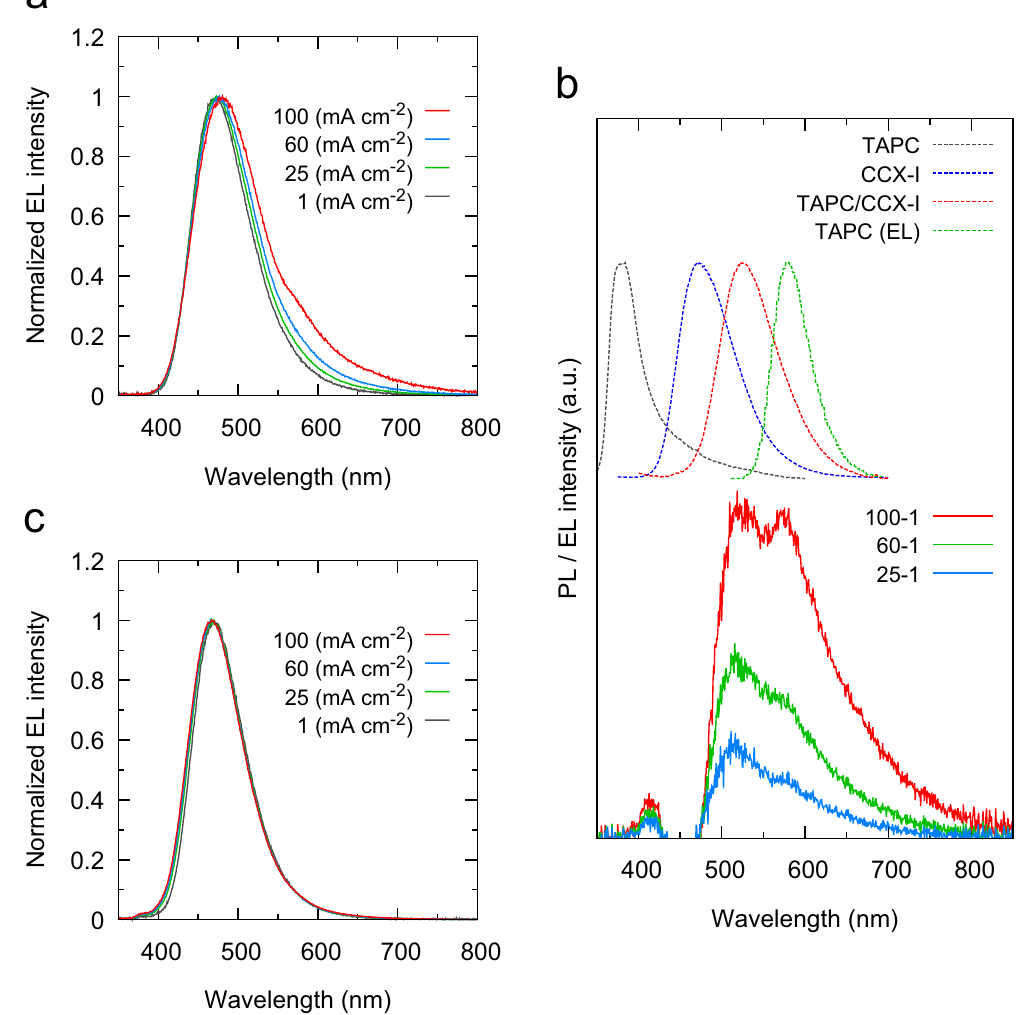
Figure 3. EL spectra of CCX-I based OLEDs. ( a ) EL spectra of CCX-I-6A at J values of 1, 25, 60, and 100 mA cm − 2 , with luminance of 88, 961, 1027, and 706 cd m − 2 , respectively. ( b ) Difference of EL spectra of CCX-I-6A (solid lines) and PL spectra of CCX-I, TAPC, and 50 wt% CCX-I:TAPC film together with EL spectrum of TAPC (dashed lines). The difference of spectra was obtained by subtracting the EL spectrum measured at J = 1 mA cm − 2 from those measured at J = 25, 60, and 100 mA cm − 2 . ( c ) EL spectra of CCX-I-6B at J of 1, 25, 60, and 100 mA cm − 2 , at which the luminance values are 133, 2278, 3783, and 5012 cd m − 2 ,